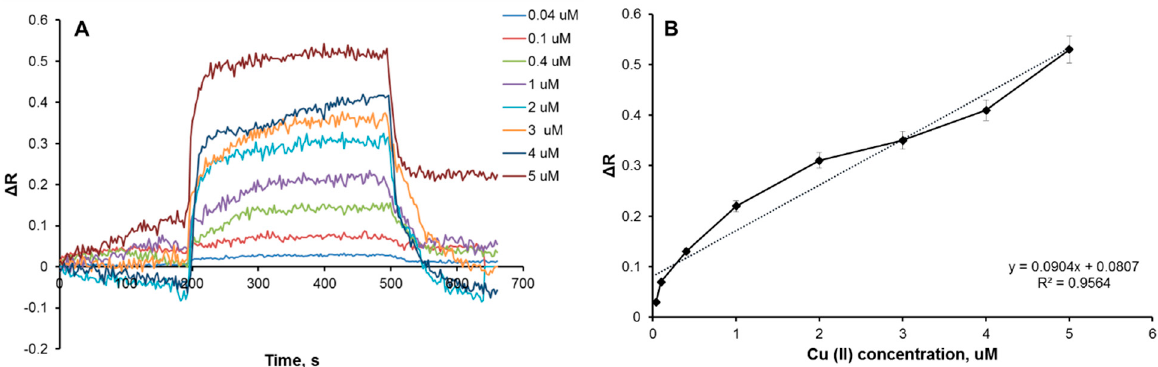
Figure 3. Real-time Cu(II) detection ( A ) and calibration curve ( B ) of Cu(II)-imprinted plasmonic